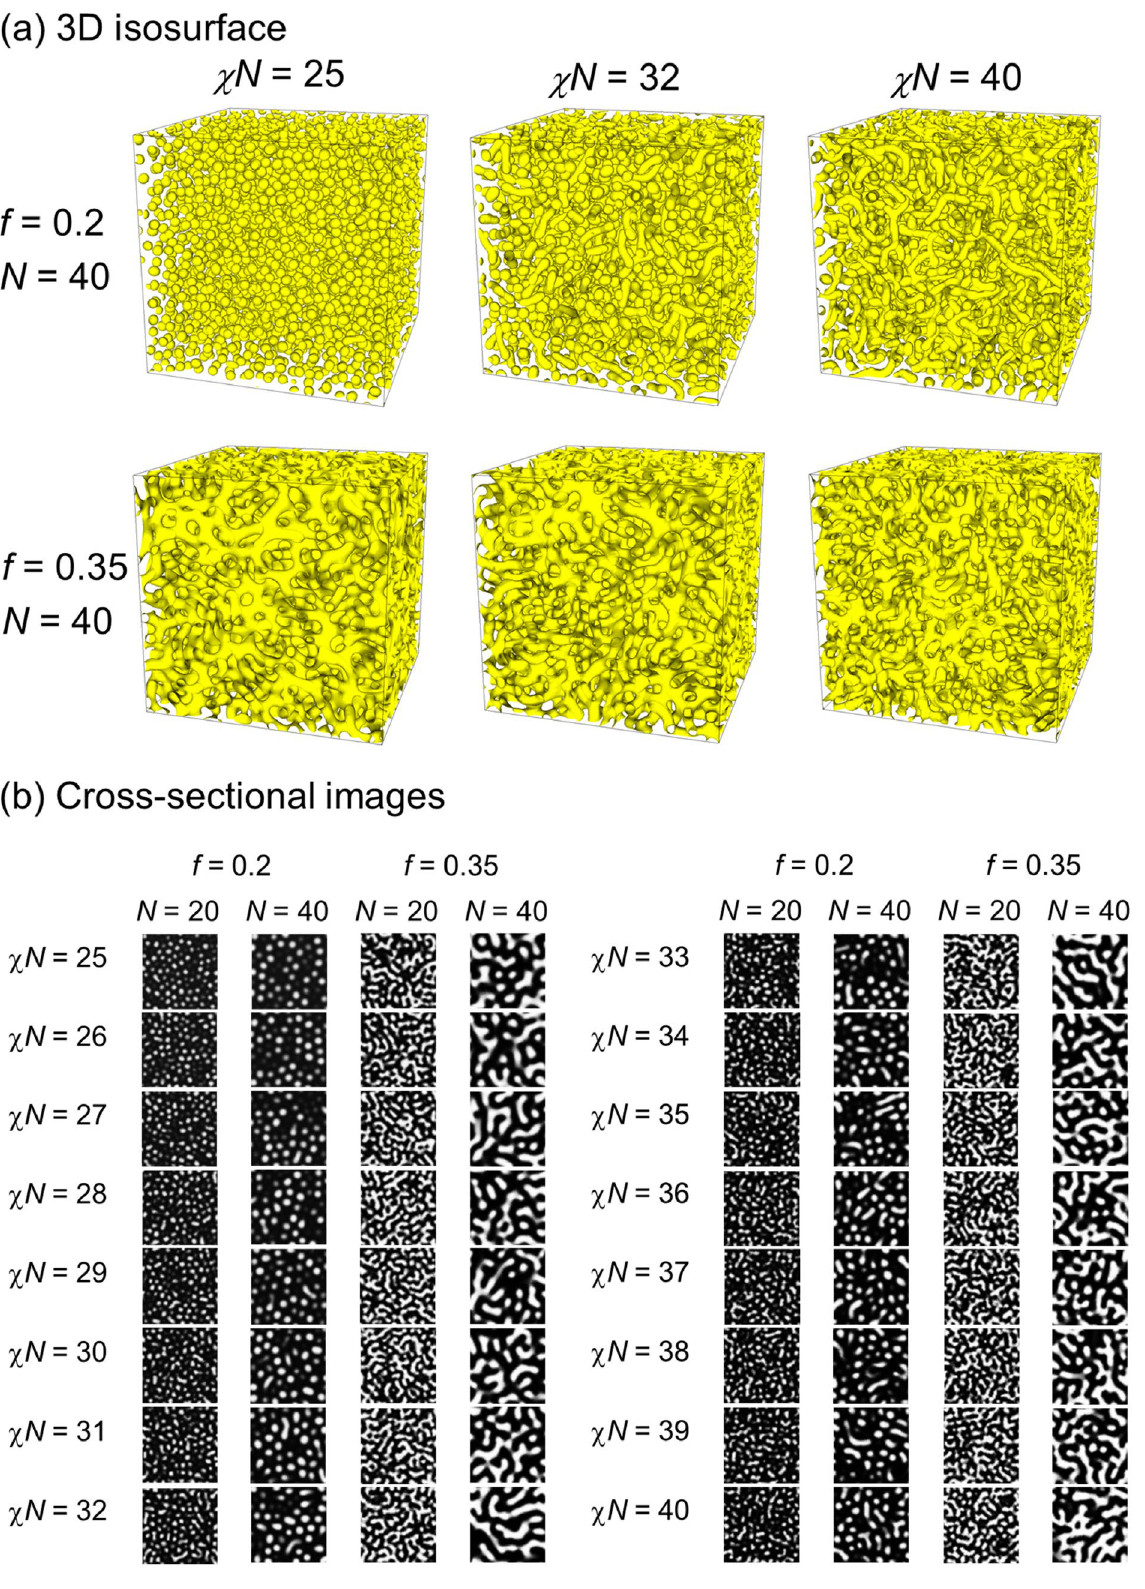
Figure 1. Snapshots of generated structures. ( a ) 3D isosurface and ( b ) cross-sectional